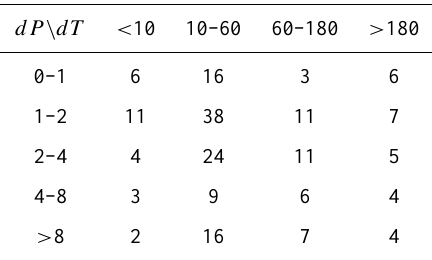
Table 1. Distribution of the amounts of studied events among dP (in nPa) and dT (in seconds)